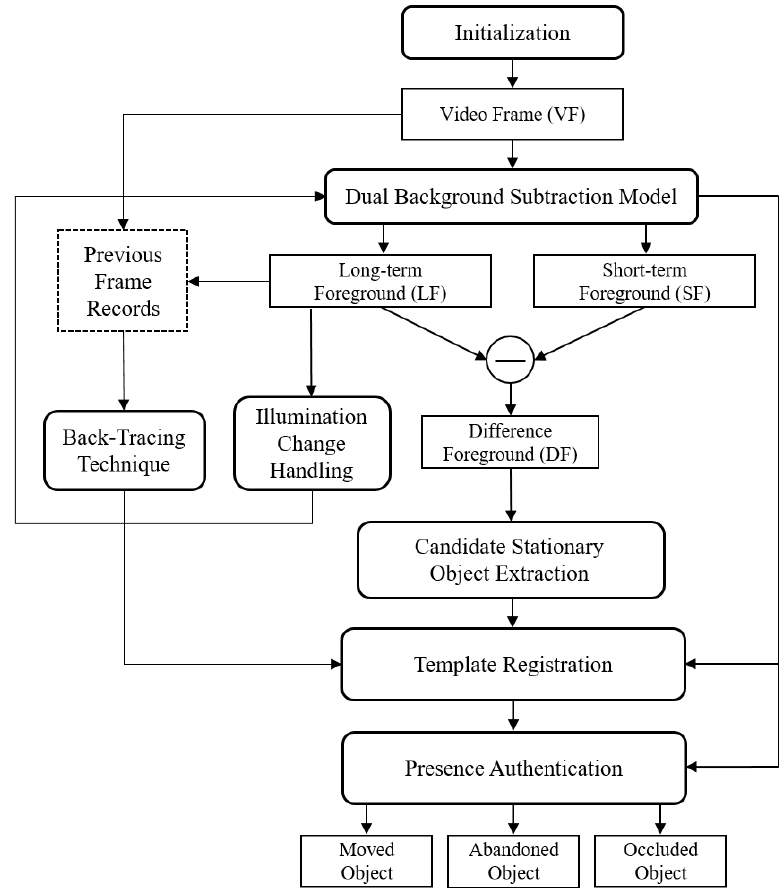
Figure 1. Framework of the proposed algorithm.